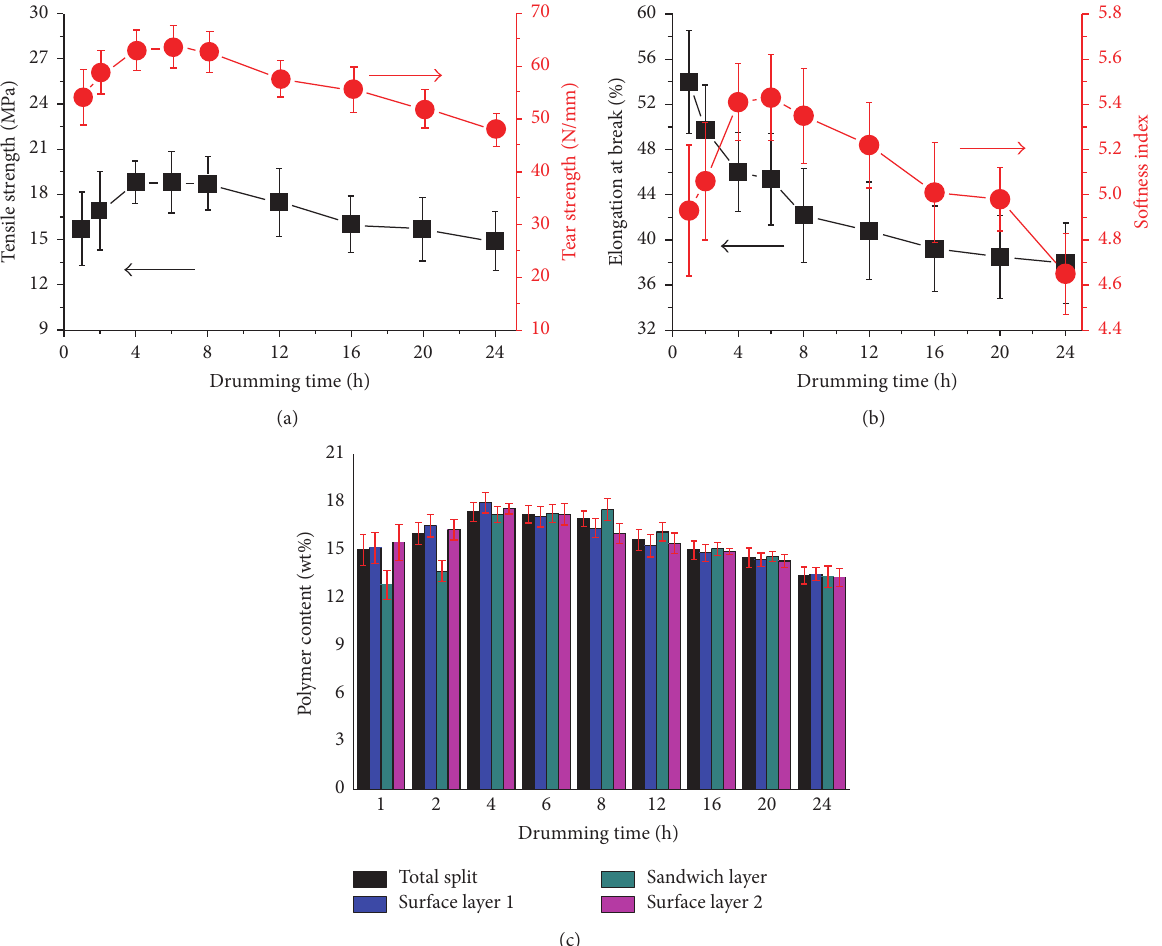
Figure 2: Effect of drumming time on physical properties and polymer contents of the PnBMA/Split composites.